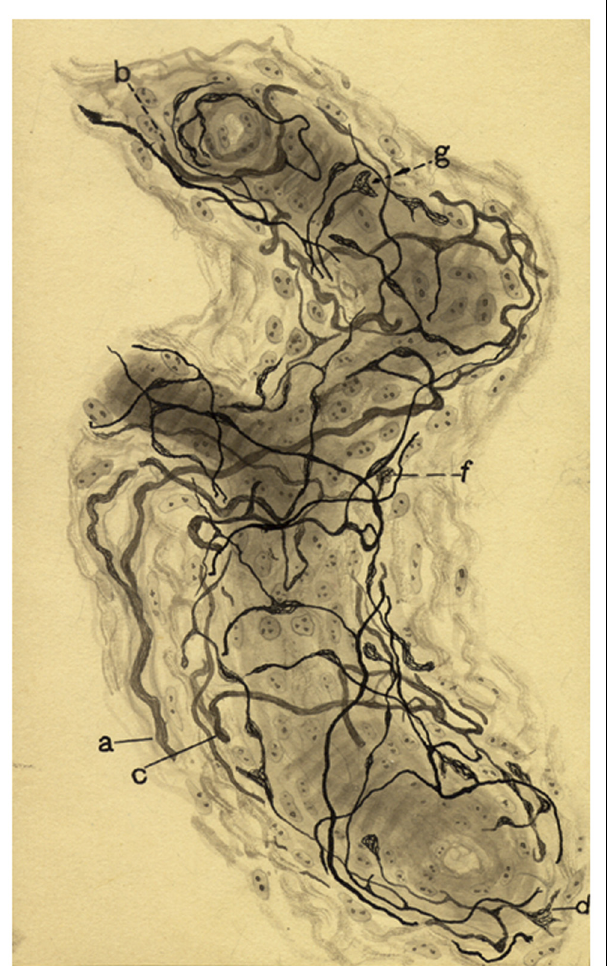
FIGURE 6 | Sensoy nervous plexus in an artery of small caliber from a dog of two months. (a,b,c) Myelinated axons. (d)Varicose nerve terminal, (g,f)Terminal meniscus.The preparation was stained by the Cajal’s reduced silver nitrate method (in de Castro, 1928; courtesy of Fernando-Guillermo de Castro from the Archive Fernando de